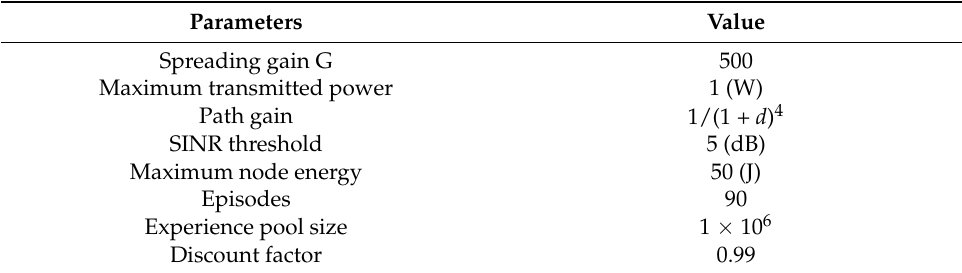
Figure 3. The agricultural WSN topology. Table 1. Sensor node